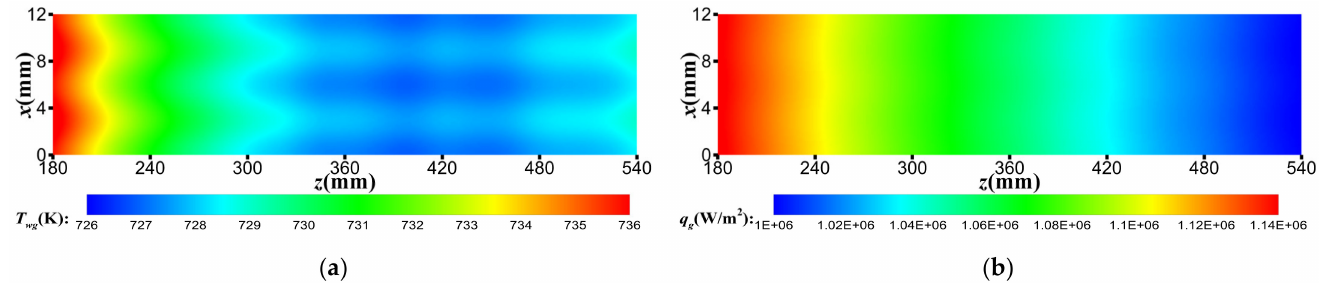
Figure 10. Distribution of T wg and q g of the gas heated surface in Case#1: ( a ) Distribution of T wg ( b ) Distribution of q g .